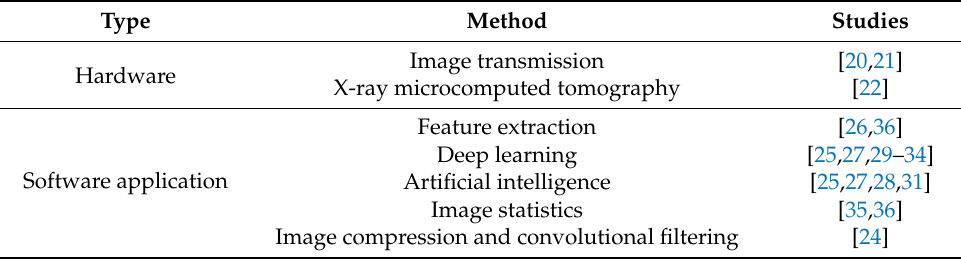
Table 1. The primary image processing approach from the related